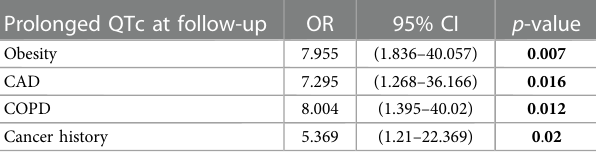
TABLE 6 Independent predictors of prolonged QT at follow-up. Prolonged QTc at